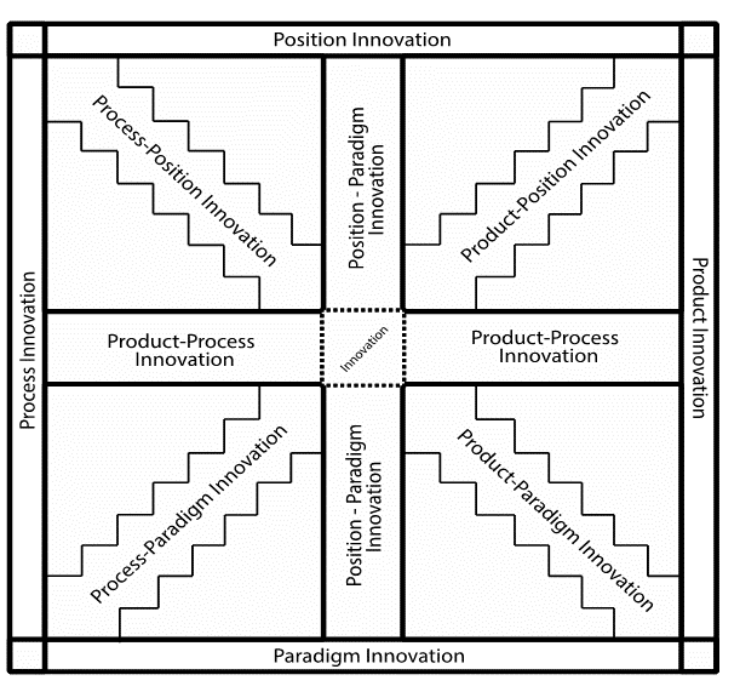
Fig. 1. 10Ps of Innovation Mapping Model (Abdel-Razek& Alsanad, 2013a,